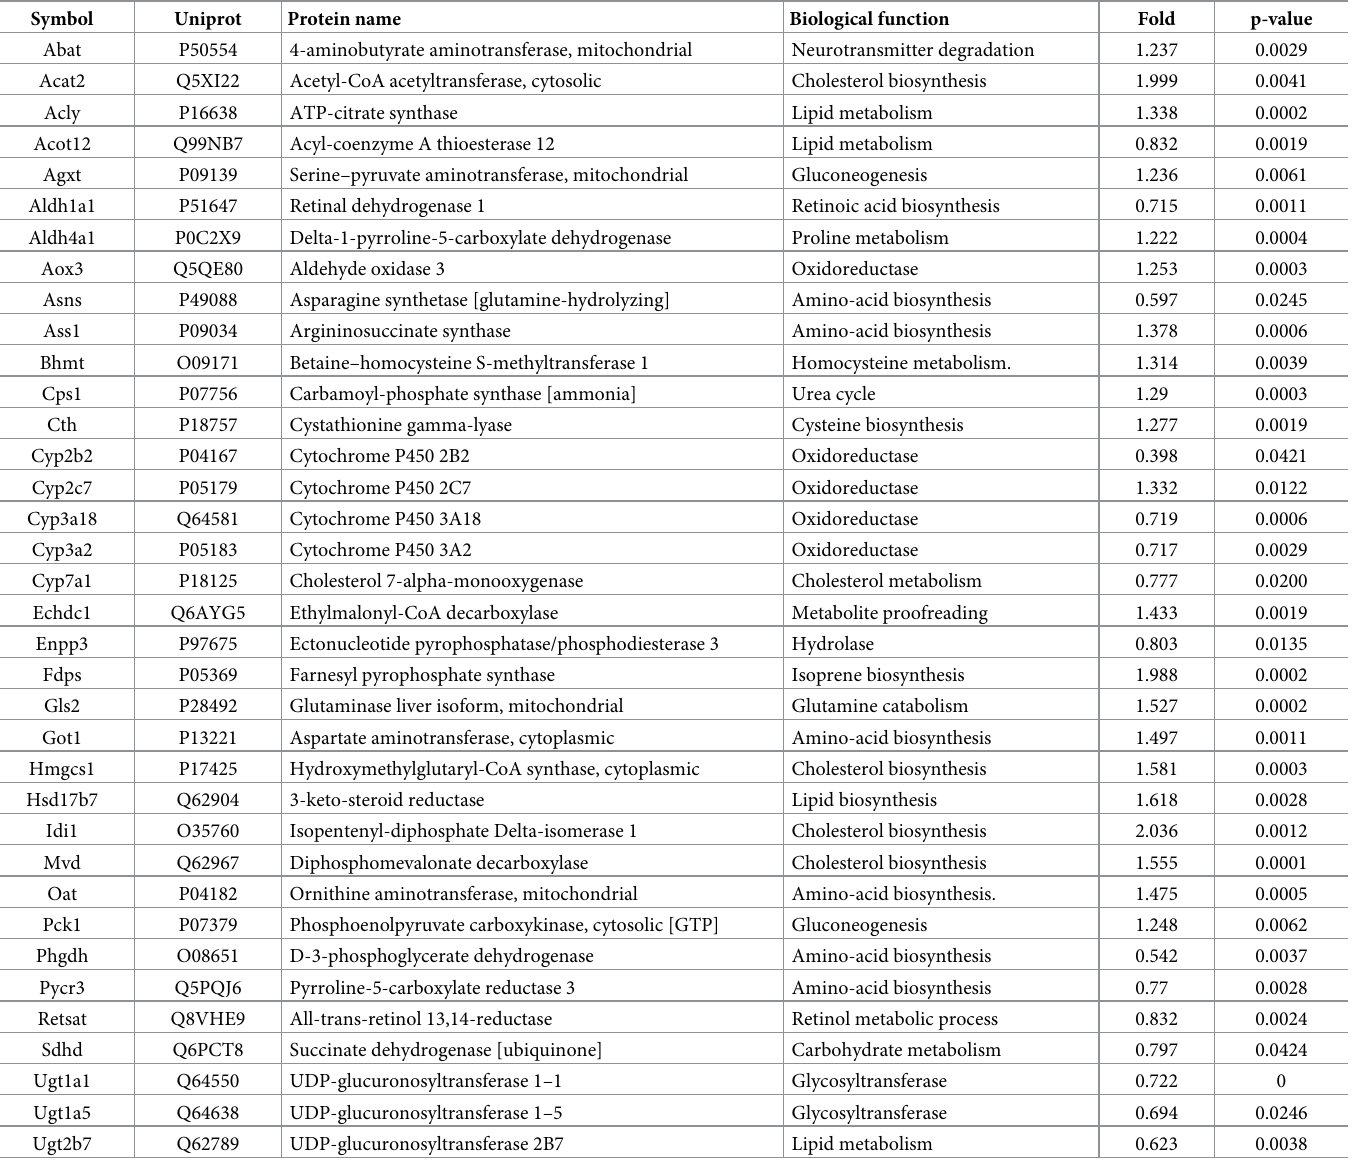
Table 3. Differential proteins involved in significantly perturbed metabolic